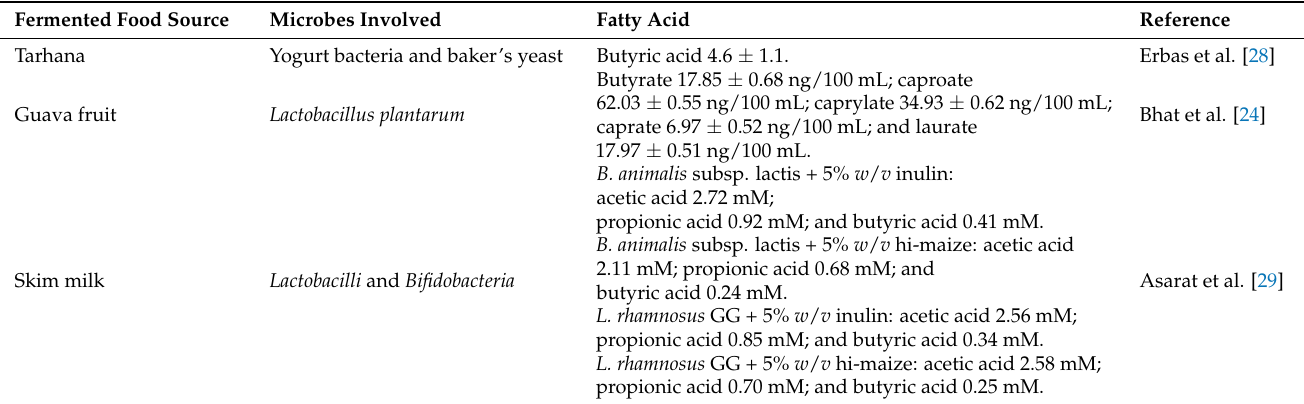
Table 1. Fatty acids from fermented foods and health